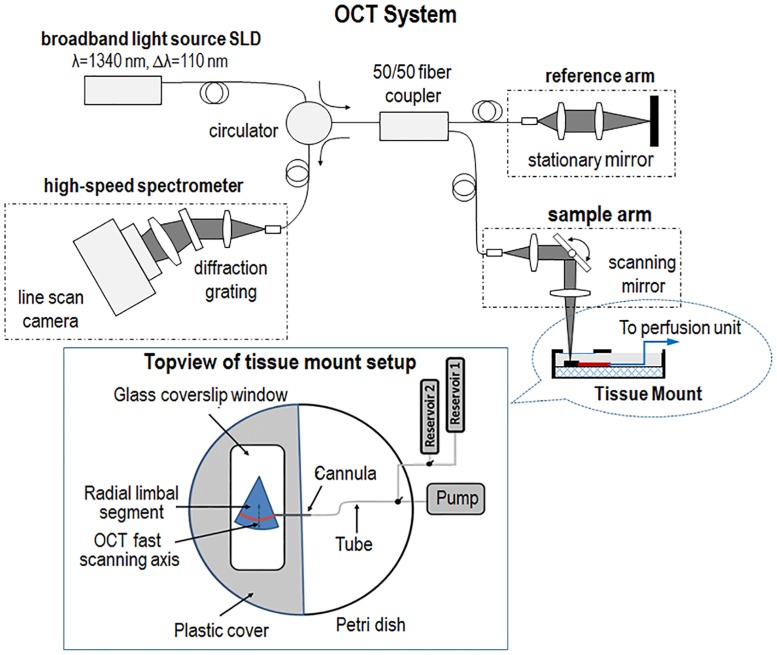
Schematic diagram of the experimental setup, including an SD-OCT system and a perfusion unit.The perfusion unit can be used to induce pressure transients. A single reservoir can control static pressures in the cannula inserted into Schlemm’s canal (SC), while switching between two reservoirs provides a means of examining dynamic changes. A radial limbal segment is placed with the trabecular meshwork facing upward toward the OCT imaging beam and a cannula is inserted into SC.